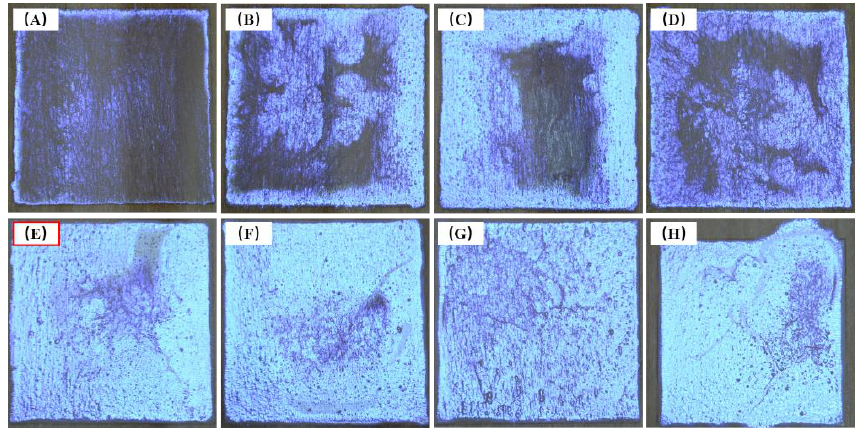
Figure 9. Photos of coatings formed by PSt emulsion with different amounts on a 35 mm × 35 mm wood surface: ( A ) 100 μL; ( B ) 200 μL; ( C ) 300 μL; ( D ) 400 μL; ( E ) 500 μL; ( F ) 600 μL; ( G ) 700 μL; ( H ) surface: ( A ) 100 µ L; ( B ) 200 µ L; ( C ) 300 µ L; ( D ) 400 µ L; ( E ) 500 µ L; ( F ) 600 µ L; ( G ) 700 µ L; ( H ) 800 µ L. 800 μL .